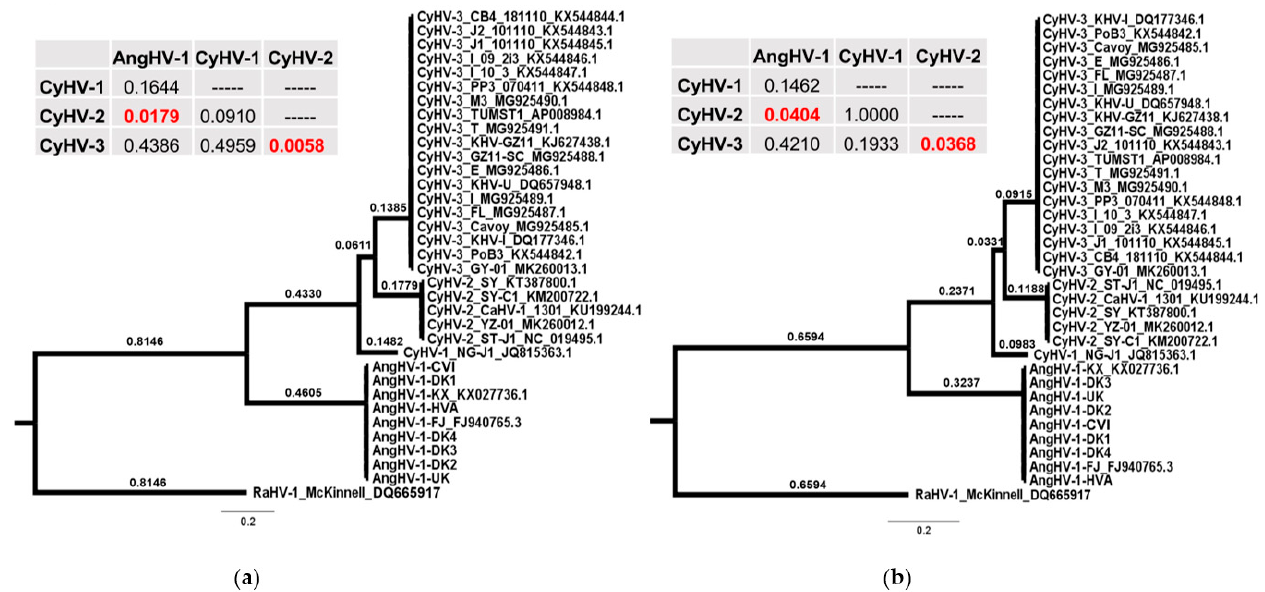
Figure 4. Relative rates of cyprinivirus evolution. ML trees were produced based on the same data used to generate the cladograms in Figure 3. ( a ) ML tree based on concatenated core gene AA sequences. ( b ) ML tree based on concatenated core gene DNA sequences excluding the third codon position. In these trees, branch lengths represent the number of substitutions per site. The results of Tajima’s relative rate tests for pairwise comparison between species clades are presented in each panel. p -values highlighted in red indicate significant differences in the rate of evolution between species. The results for Tajima’s relative rate tests presented in panel ( b ) were obtained by considering transversions only. Equivalent tests, considering transitions only, are presented in Table S4.